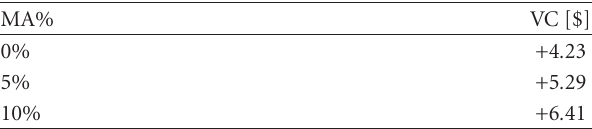
Table 5: Void coe ffi cient as a function of MA-loading in the core, in dollars between fully pressurized and atmospheric